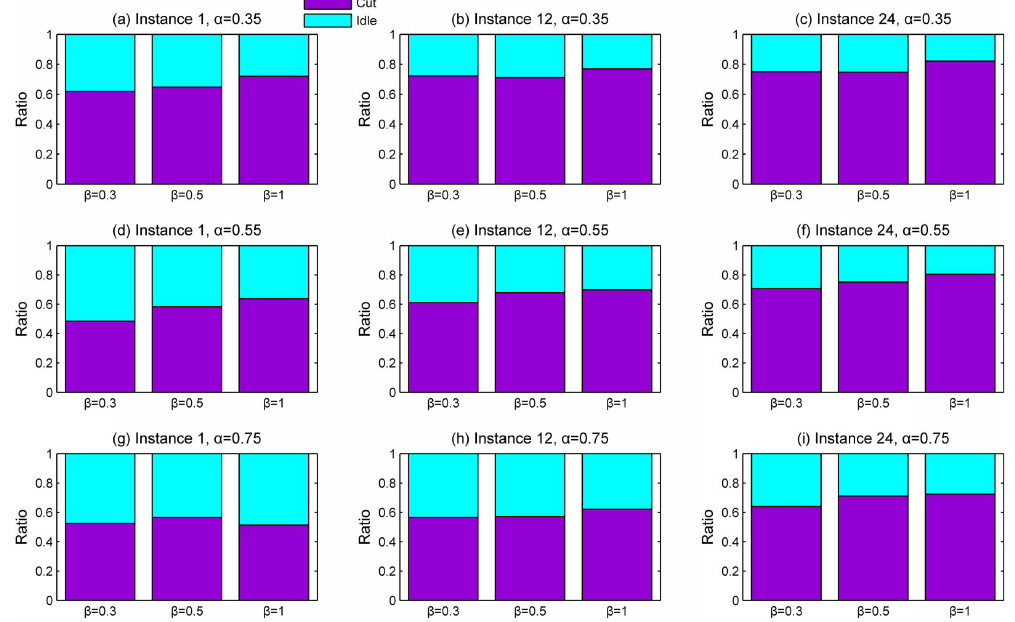
Figure 11. The proportion of energy